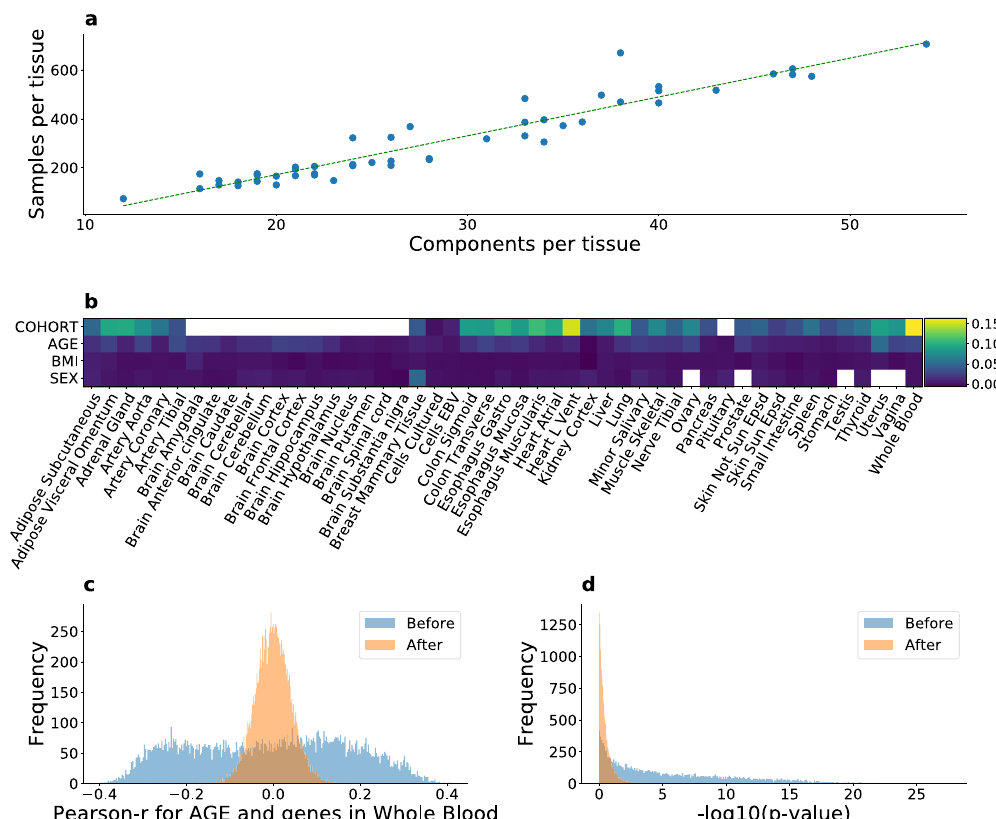
Fig. 2 Confounding due to unmodelled factors. a Relationship between the number of inferred factors and tissue sample size. Fitted line ( r ≈ 0.95, p ≈ 5.4 × 10 − 26 ) corresponds to a linear least-squares regression. The two-sided p -value is based on the null hypothesis that the slope is zero, using the Wald Test with t -distribution for the test statistic. b The difference in the variance of the distribution of Pearson correlation values for each tissue over all genes, before and after correction. Empty cells correspond to tissues in which only one value of the confound is available. The "Cohort'' variable undergoes the most substantial change after the correction across all tissues. c Distribution of Pearson correlation between the expression of a gene in whole blood and age, before and after correction. After the correction, the correlation values move towards zero and show considerably less dispersion. d The p -value distribution from panel c ’ s, in logarithmic space. The enrichment for signi fi cant (low) p -values is greatly attenuated after the correction, suggesting that unmeasured variables can induce spuriously signi fi cant